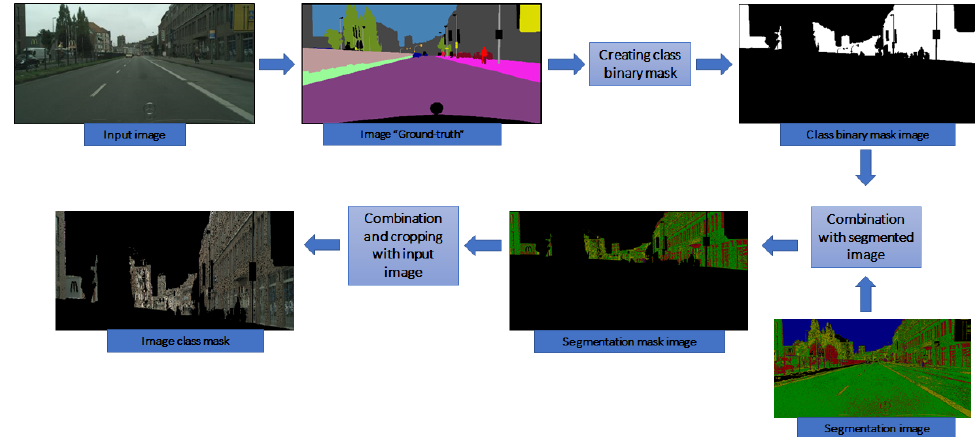
Figure 9. Class mask obtained from a segmented image to generate patches for the category building . A similar process is followed for all the categories to process the training dataset.